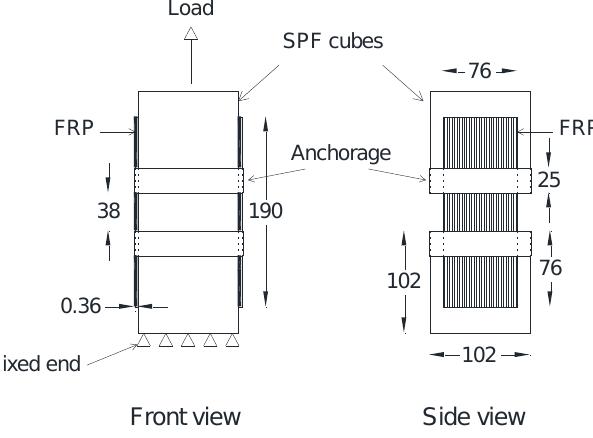
Figure 13. Anchored Double Shear Model (TCLS-A) Table 4. Comparison of direct shear test models with and without anchorage.